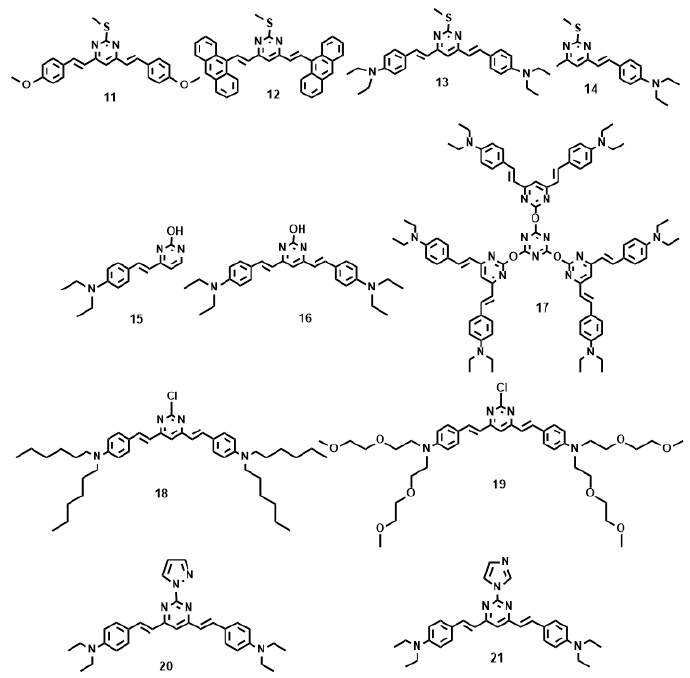
Figure 4. The molecular structures of 11 – 21 .